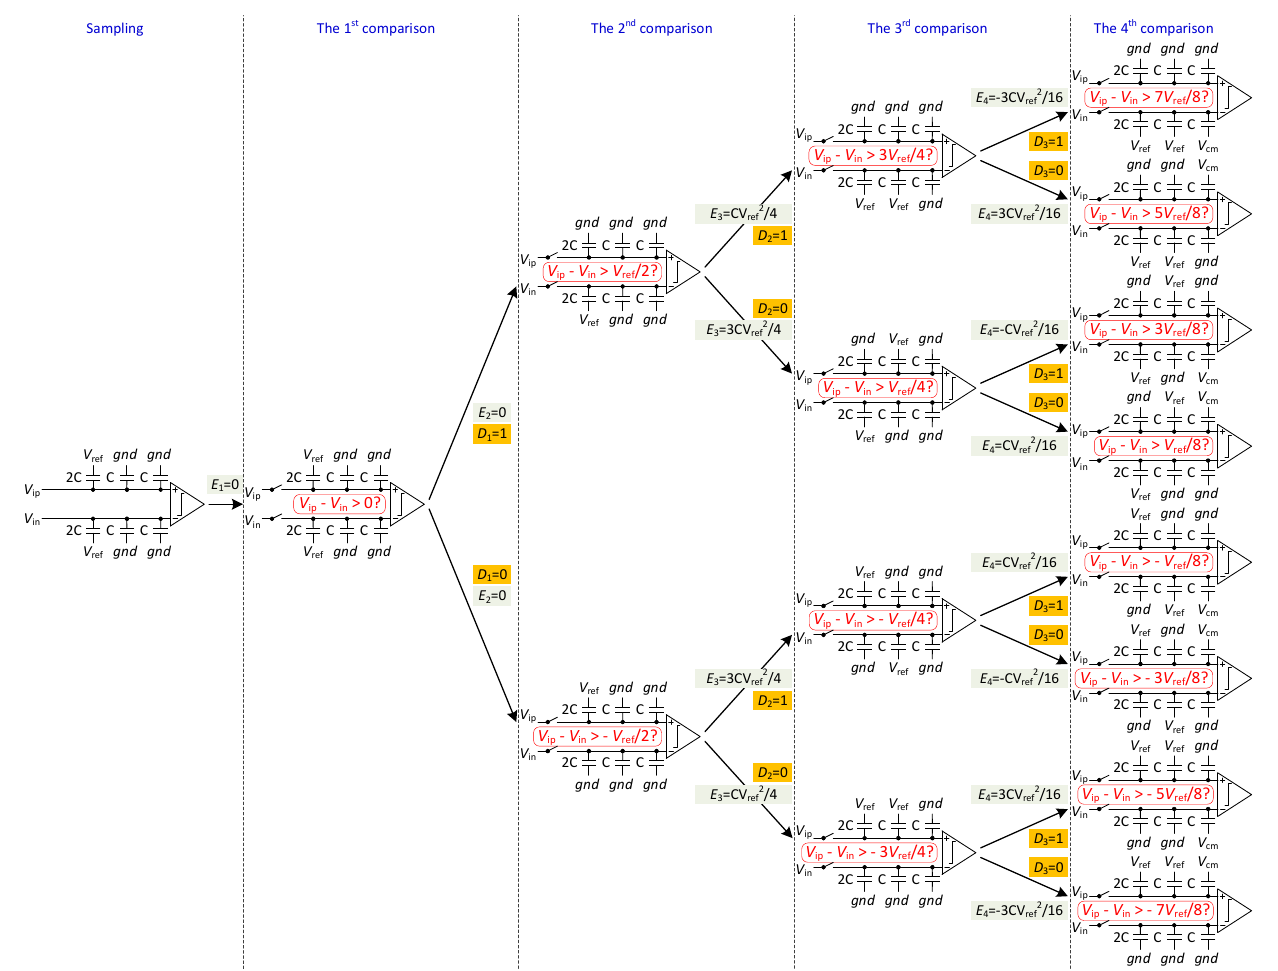
Figure 4. Switching procedure of 4-bit SAR DAC.